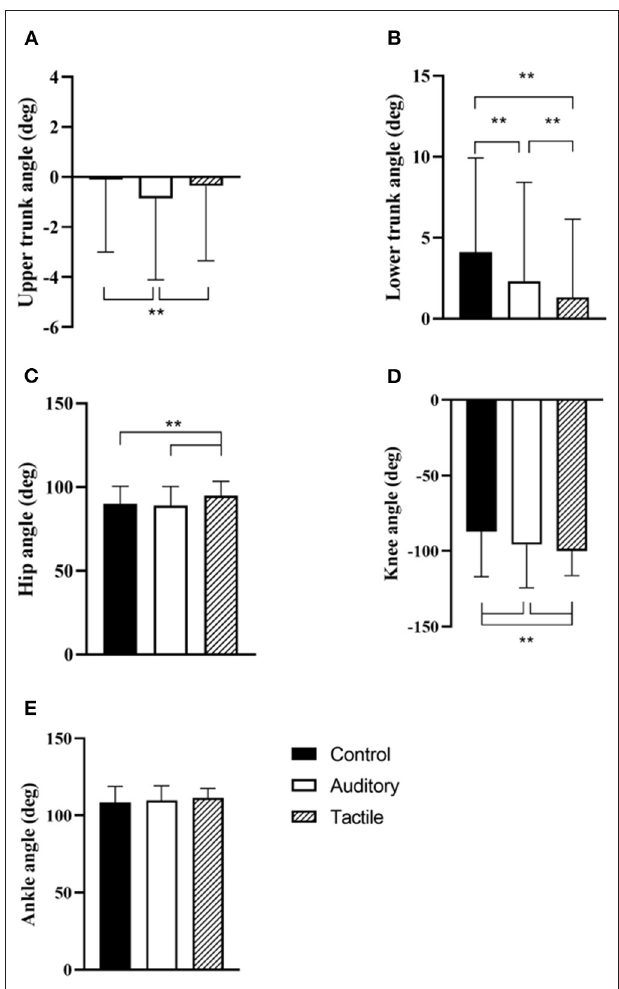
FIGURE 3 | Condition effect in the acquisition phase for peak upper trunk (A) , lower trunk (B) , hip (C) , knee (D) , and ankle (E) flexion angles. ** indicates p <